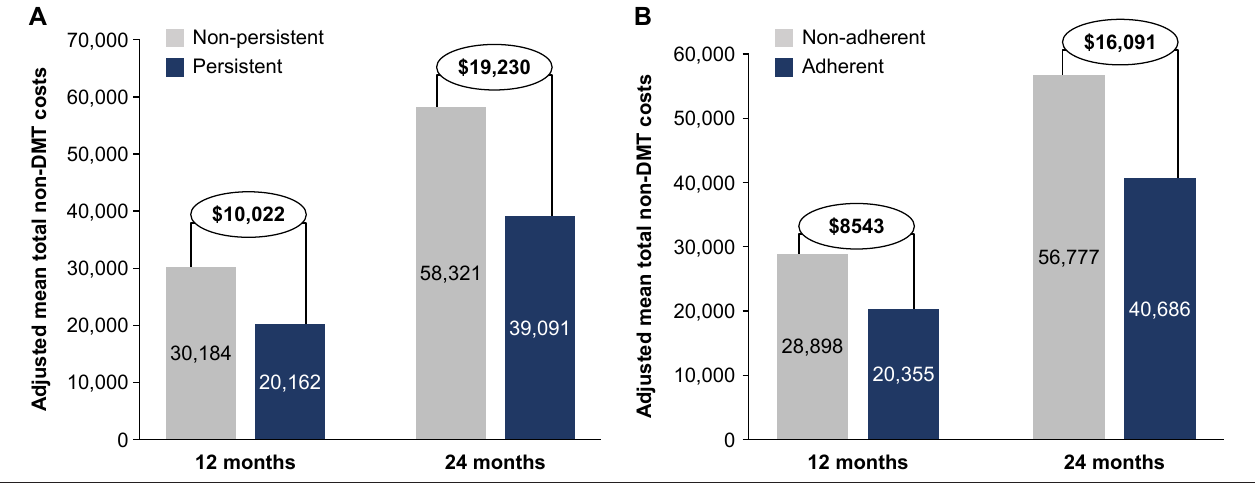
Figure 1. Adjusted All-Cause Non-DMT Costs at 12 and 24 Months in ( A ) Nonpersistent vs Persistent Patients or ( B ) Nonadherent vs Adherent